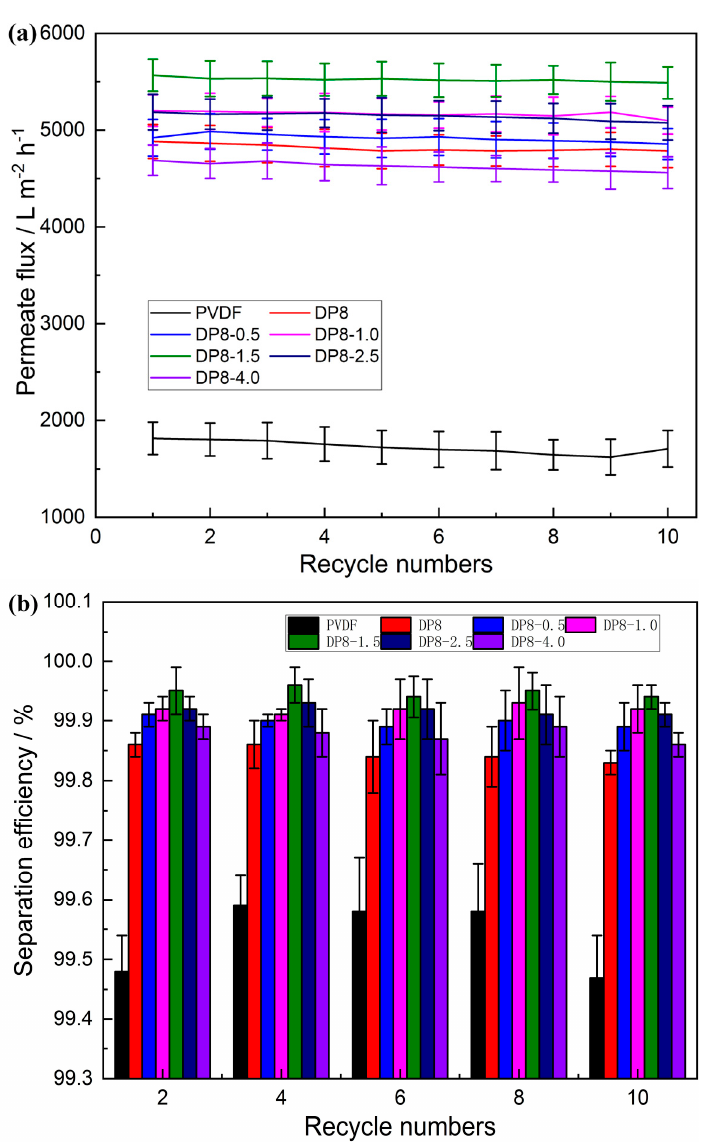
Figure 6. ( a ) Oil–water separation flux ( b ) efficiency of PVDF nanofiber membrane and DP–X layered membrane.